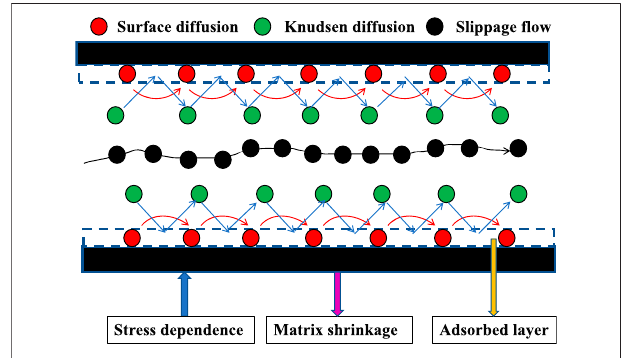
FIGURE 1 | Schematic of the gas transport mechanism in the organic